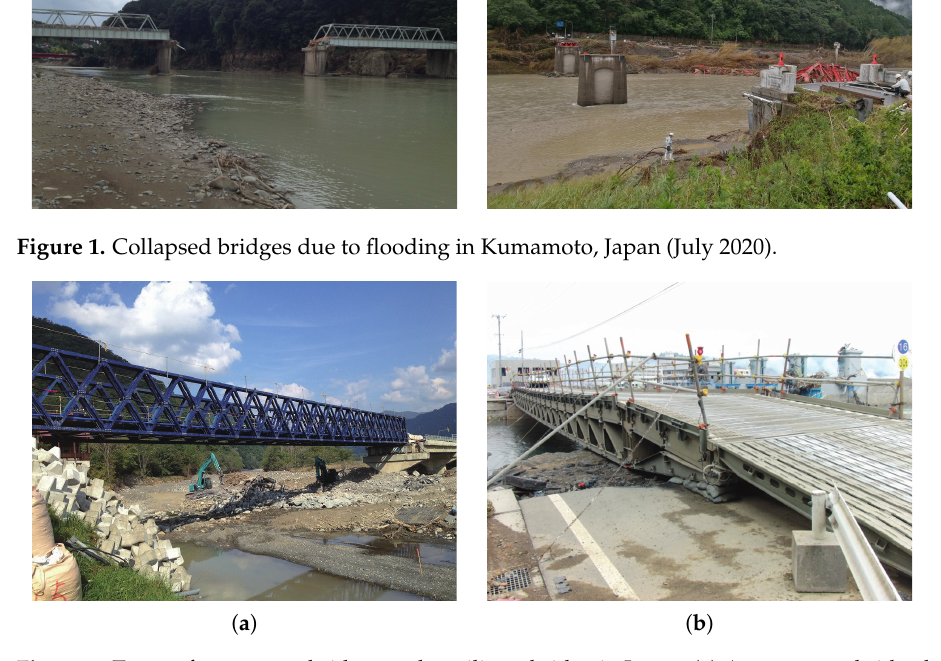
Figure 2. Types of temporary bridges and a military bridge in Japan. ( a ) A temporary bridge built by a company. ( b ) A temporary bridge built by the